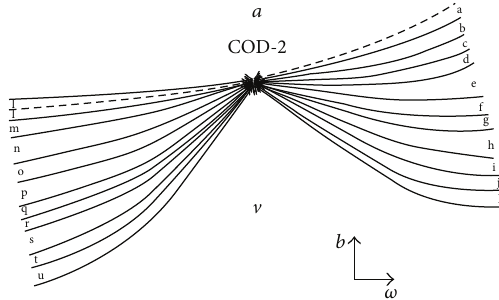
Figure 8: Unfolding diagram near a codimension-two grazing bifurcation